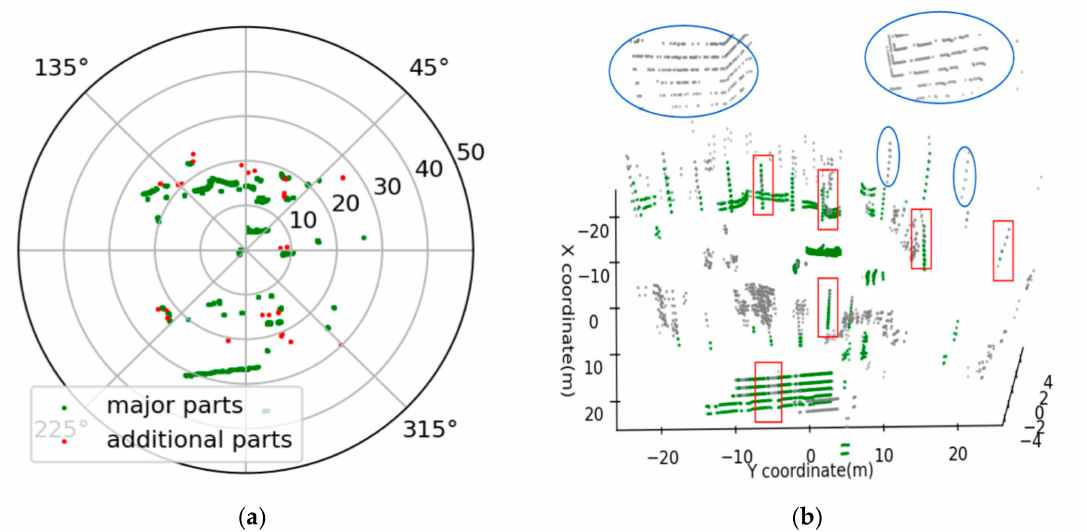
Figure 5. A snapshot of extracting major parts from the point cloud by clustering points in the key region. ( a ) The results of clustering projected points in the key region. ( b ) The results of extracting major parts in 3D